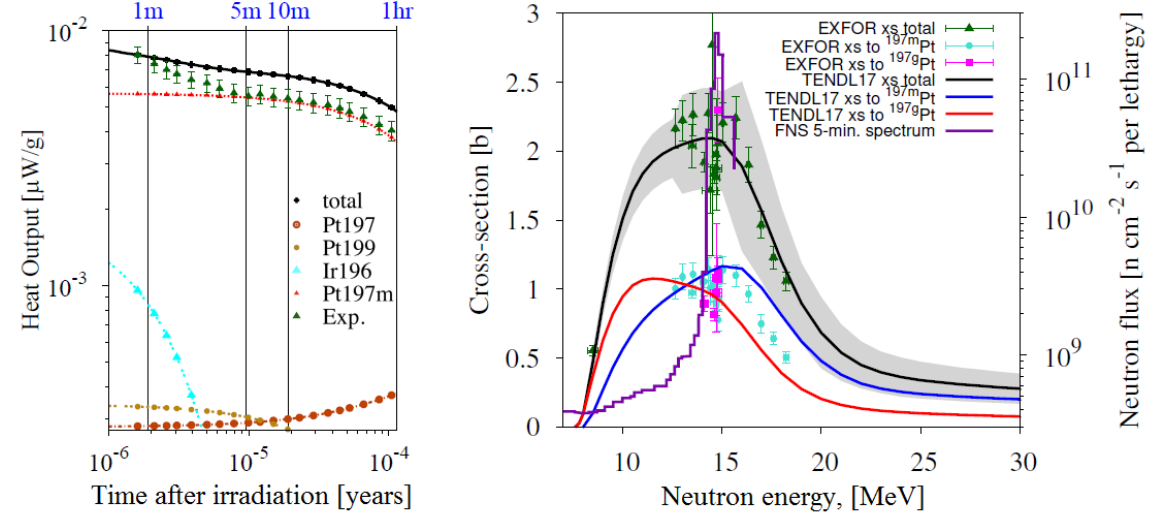
Figure 3: FISPACT-II&TENDL-2017 simulation results for the decay-heat experiment for platinum (left) in the FNS benchmark, [4], and TENDL-2017 cross-section for 198 Pt(n,2n) reaction channel along with the EXFOR experimental data